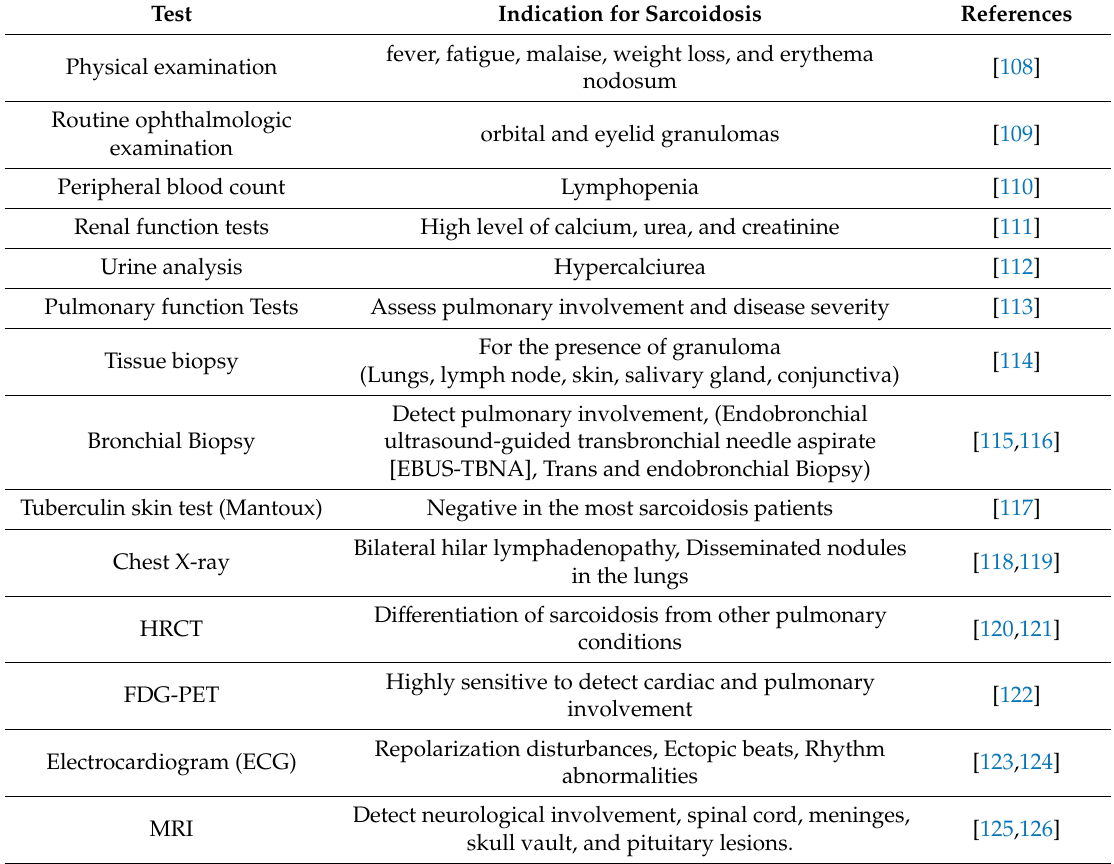
Table 2. A list of conventional diagnostic tests for sarcoidosis. Indication for